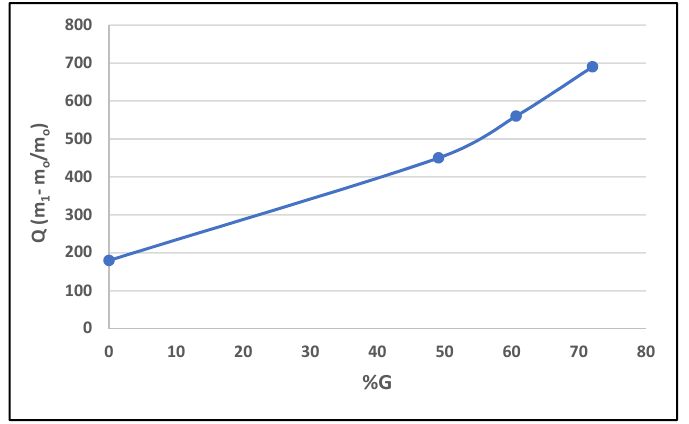
Figure 5. Water absorption capacity as a function of the percentage of graft.